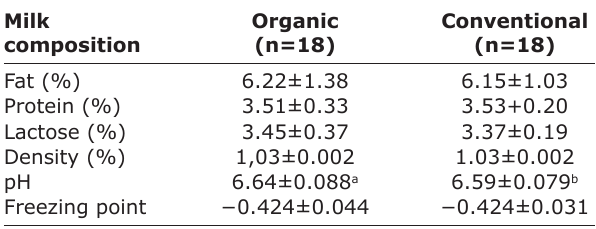
Table-2. Caprylic acid (C8:0) and capric acid (C10:0) of organic goat milk are higher than conventional goat conventional goat milk are higher than organic goat milk. The total fatty acid of organic goat milk is higher than conventional goat milk. Table-1: Chemical and physical composition of organic and conventional goat milk. Milk composition